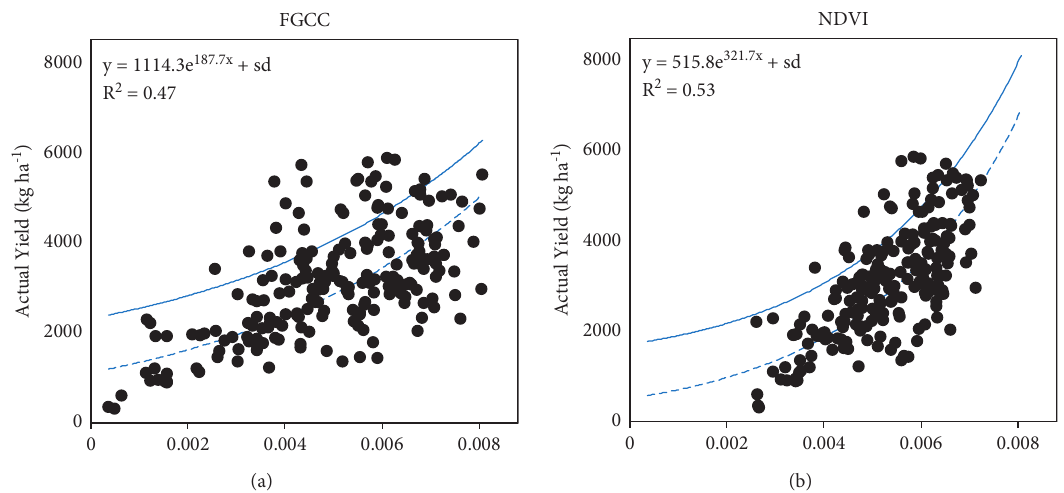
Figure 5: The model built from both sensor types and their subsequent yields. INSEY (In-Season Estimate of Yield) is derived from dividing sensor values (in this case) by GDD > 0, which creates a unit of growth per day, in order to estimate yield. The dotted line and coefficient of determination ( r 2 ) represents the model that is built from the dataset, and the solid line, as well as the equation, represents that same model translated up one standard deviation. This translation is done to represent reaching for the maximum potential yield for a location. While NDVI derived equation provides higher r 2 value, the models are similar in shape, supporting the use of FGCC as a yield